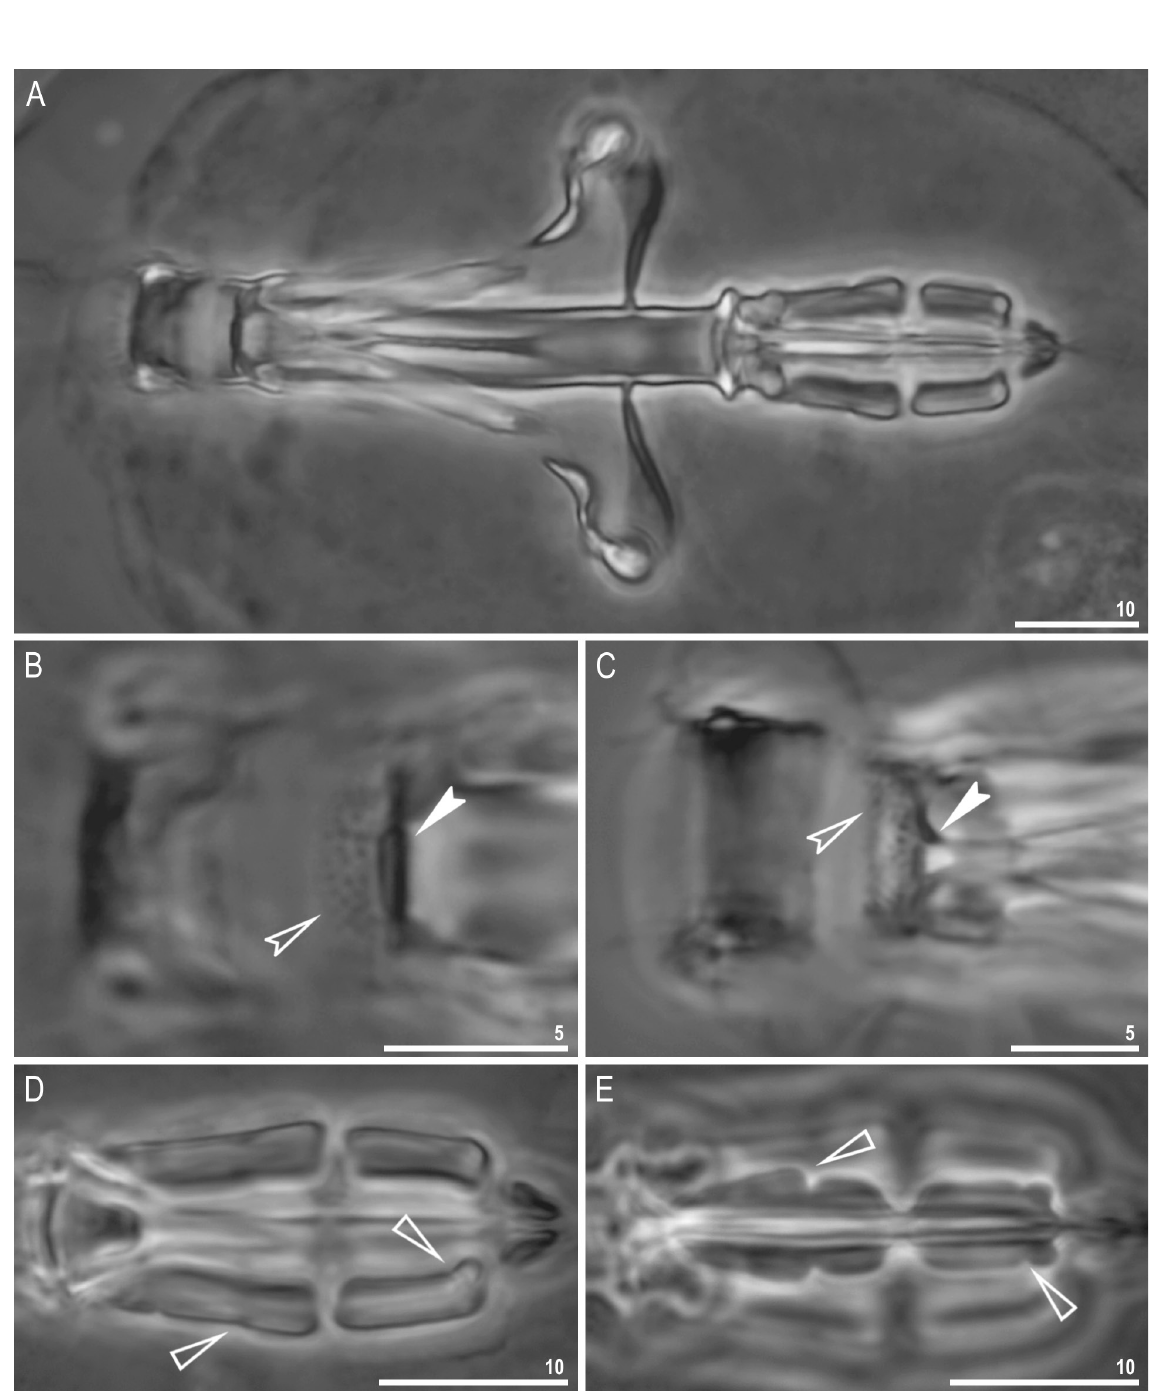
Fig. 4. Macrobiotus noongaris sp. nov., buccal apparatus and the oral cavity armature seen in PCM (paratypes, IZiBB). A . Dorso-ventral projection of the entire buccal apparatus. B–C . Oral cavity armature visible in dorsal (B) and ventral (C) views, respectively. D–E . Placoid morphology visible in dorsal (D) and ventral (E) views, respectively. Empty indented arrowheads indicate the second band of teeth in the oral cavity, filled indented arrowheads indicate the third band of teeth in the oral cavity, empty flat arrowheads indicate central constrictions in first macroplacoids and subterminal constriction in second macroplacoids. Scale bars in